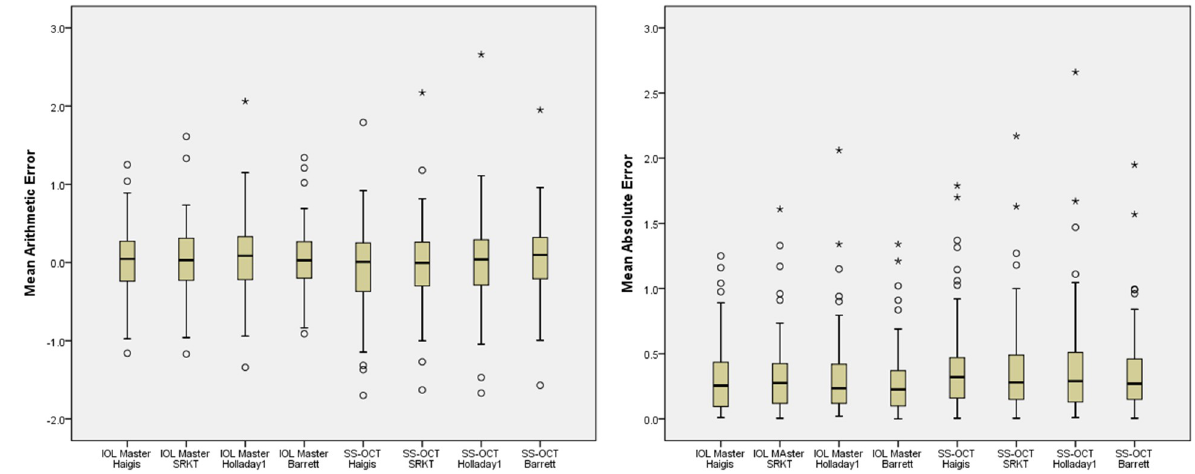
Fig 2. Box plot of mean arithmetic error and mean absolute error of IOL power calculated with four formulas. Round mark (o) means outlier values which are between one and a half and three box lengths; asterisk( � ) means extreme values which are more than three box lengths.